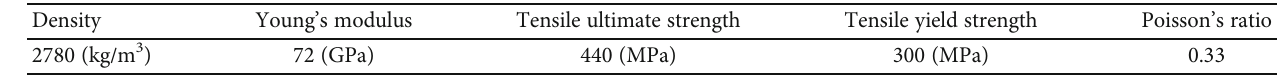
Figure 3: The 3D model of the fi tting joint. Table 1: The main parameters of D16T aluminum alloy.